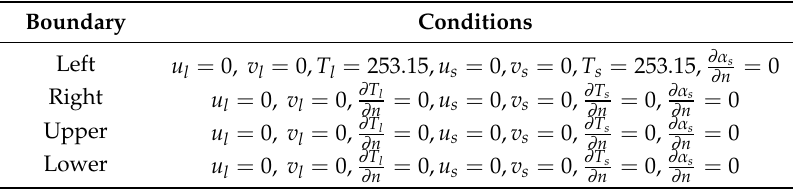
Table 1. The settings of the boundary conditions (model validation).